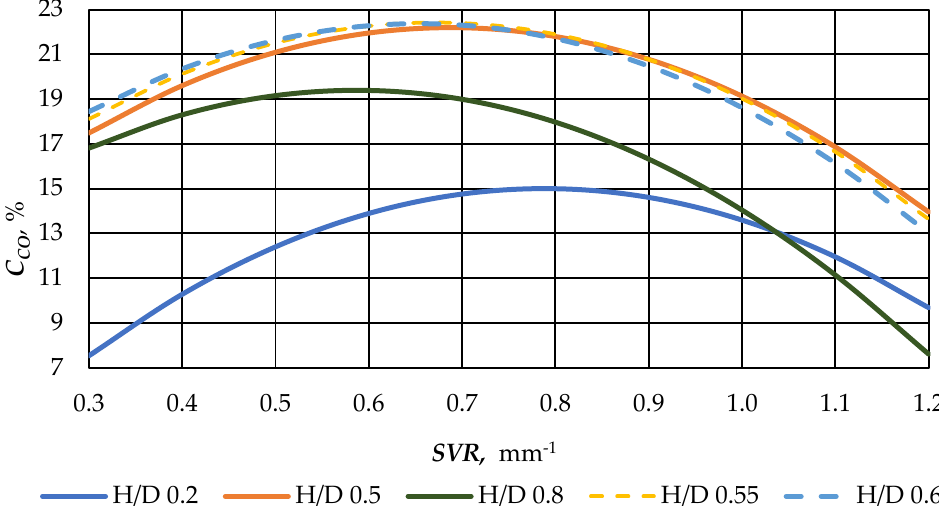
Figure 5. Graphic image of the dependence of CO concentration in the received gas on the ratio indicators of height to the reduction zone diameter ( H/D ).